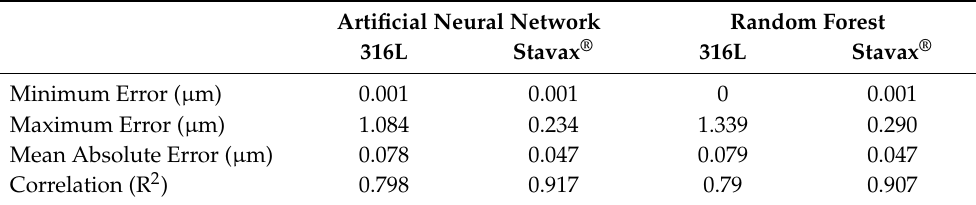
Figure 3. Comparison of predicted and measured surface roughness Sa for RF ( a ) and ANN ( b ) for both materials: 316l (blue) and Stavax (red). The initial roughness for both samples is shown as dotted lines. The maximum absolute error (MAE) for the three ranges: lower 25%, upper 25%, and in between, is shown in the corresponding table. Table 3. Evaluation of ANN and RN prediction accuracy for the surface roughness